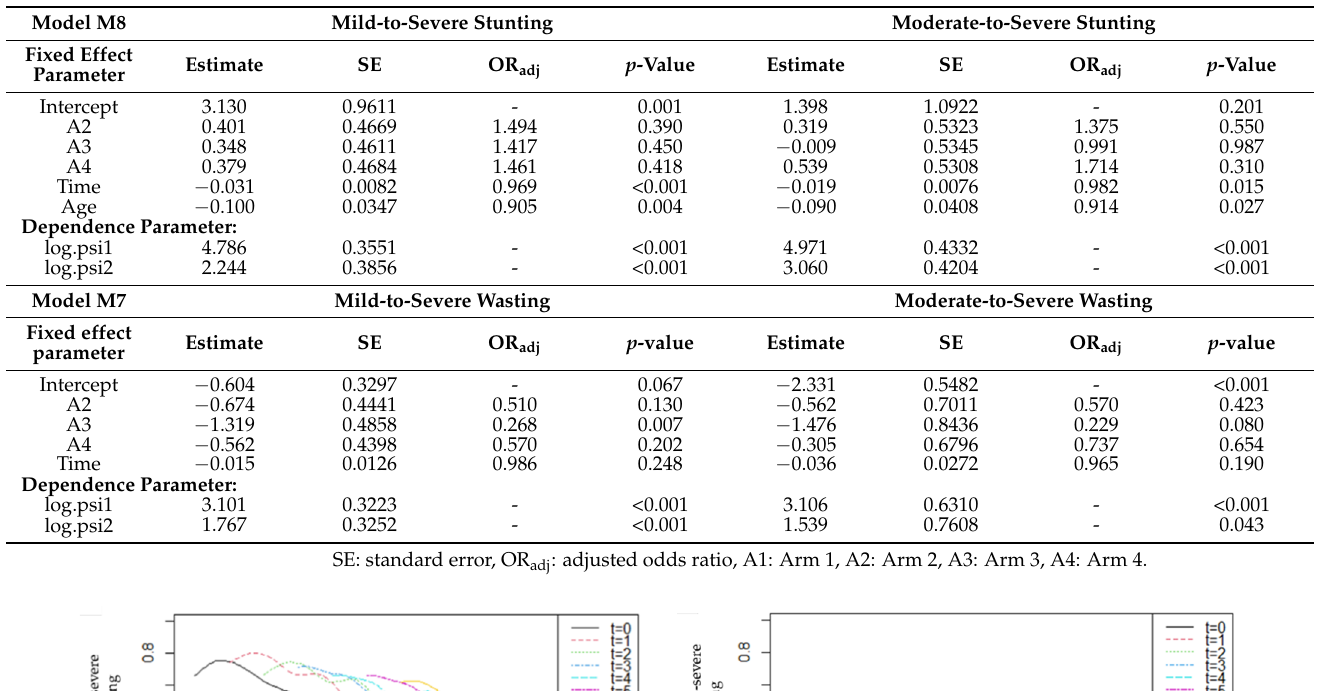
Table 4. Selected models for binary outcomes of stunting and wasting (mild-to-severe and moderate- to-severe degrees).